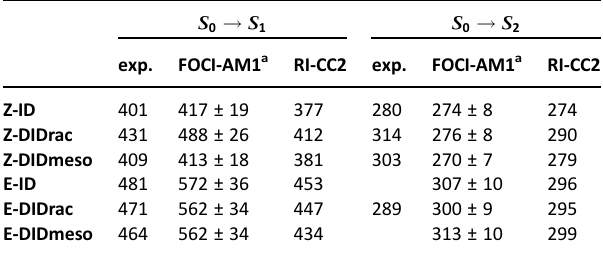
Table 4. Vertical excitation energies for the ID , DIDrac , and DIDmeso isomers.